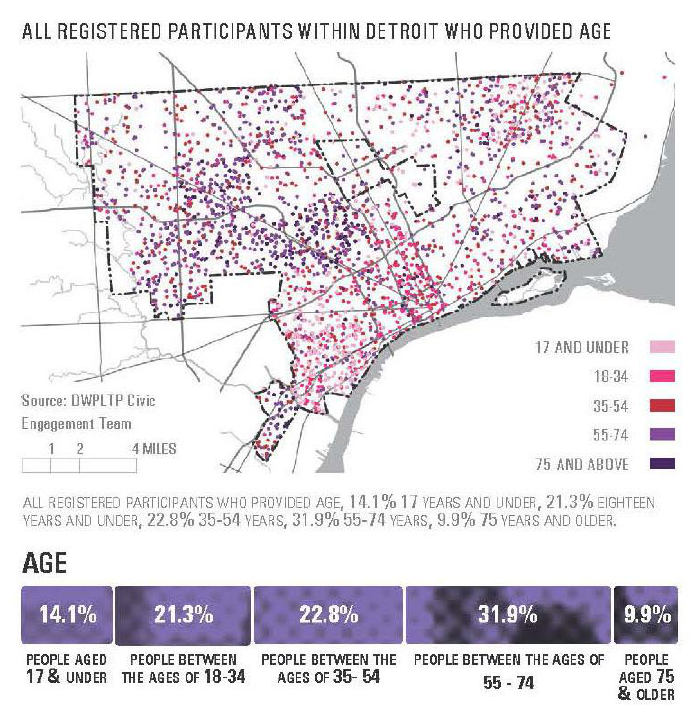
Figure 10. Map of all registered participants of DWPLTP within Detroit who provided geography. (Image credit: Detroit Future City: 2012 Detroit Strategic Framework